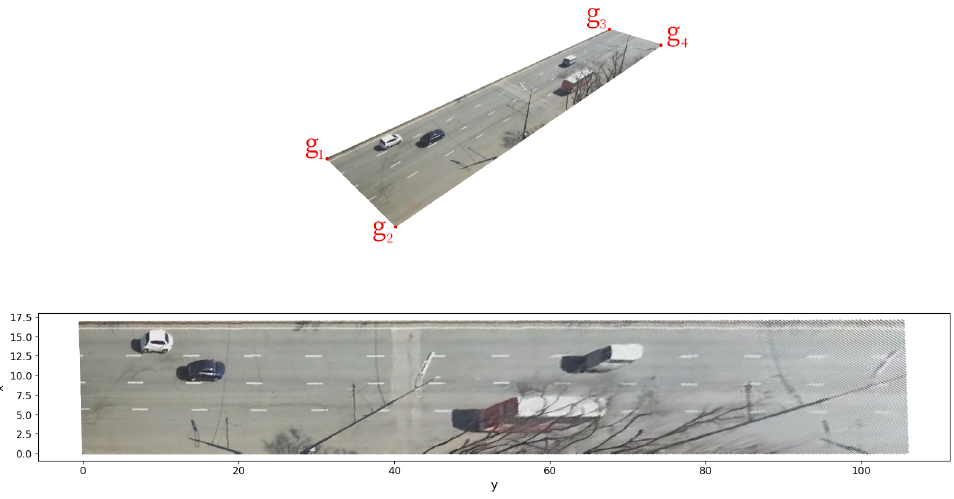
Figure 6. The Q π set visualization in plane Π , by the colors of the pixels from ˆ Q im . Given the geometry of the sample, y π is the horizontal axis, x π the